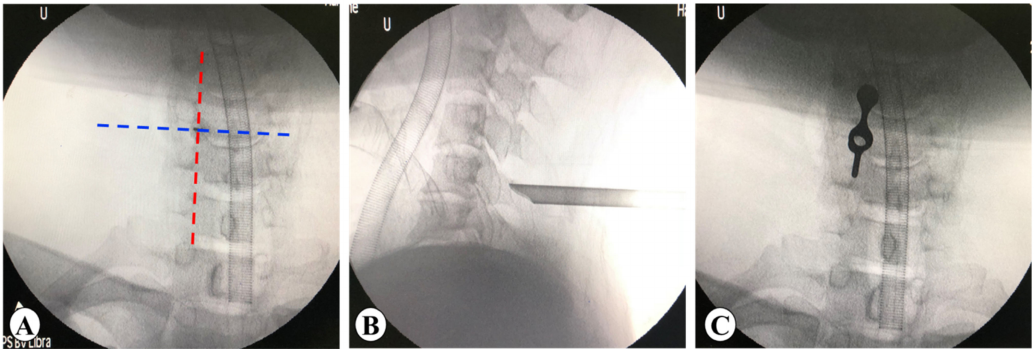
Figure 5. Location of target point in PE keyhole surgery. ( A ) Blue dotted line: the horizontal line of the intervertebral space. Red dotted line: the medial line of the lateral mass. ( B , C ) Imaging position of PE working cannula.